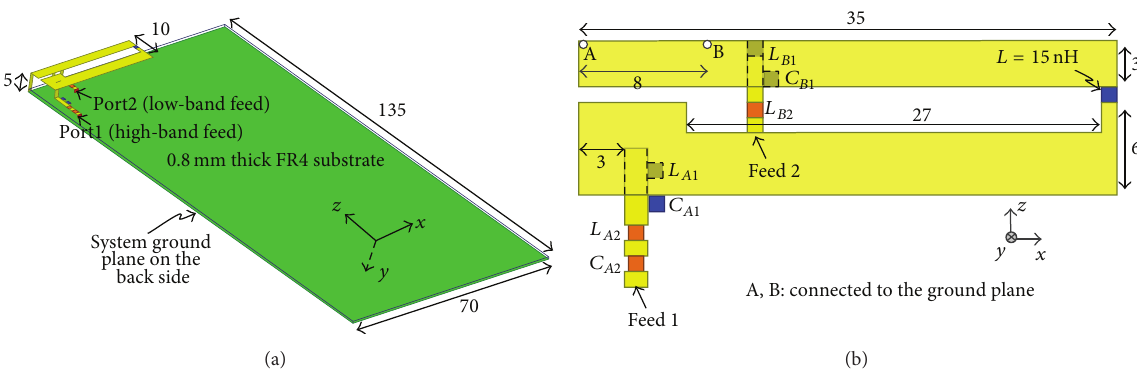
Figure 1: Proposed dual-feed PIFA configuration. (a) Geometry of the PIFA. (b) Detailed dimensions of the PIFA ( 𝐿 𝐴1 = 2.2 nH; 𝐿 𝐴2 = 6 nH; = 3 nH; 𝐿 = 17 nH; 𝐶 = 0.9 pF; 𝐶 = 2.4 pF; 𝐶 = 4 pF). All dimensions are in millimeters. The reference system used to analyze 𝐿 𝐵1 𝐵2 𝐴1 𝐴2 𝐵1 the antenna structure is also